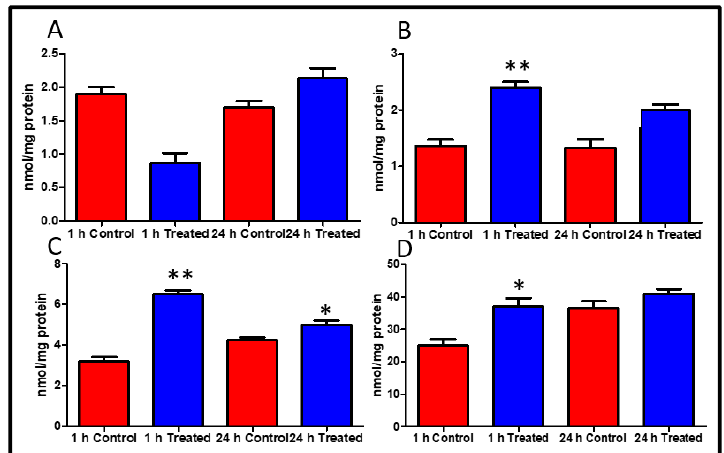
Figure 3. ( A ) AMP, ( B ) ADP, ( C ) ATP, and ( D ) changes in phosphocreatine levels in left ventricular tissue of the heart in FTY720treated groups and control-saline treated group at 1 and 24 h of reperfusion. AMP: adenosine monophosphate. ADP: adenosine diphosphate. ATP: adenosine triphosphate. Data presented as a mean ± SD. p -value < 0.05 considered as significant. ( ∗ p < 0.05 and ∗∗ p < 0.001, treated vs. control).